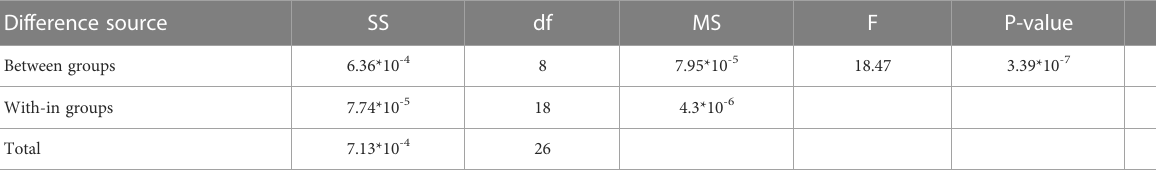
TABLE 3 The result of Single-factor analysis of variance with different groups. Difference source